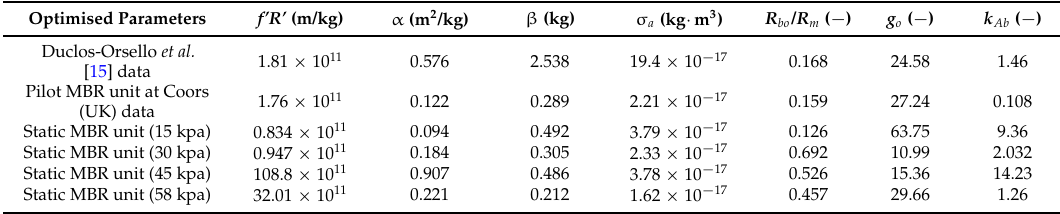
Table 3. Simulations best fit model parameters including hydrodynamic